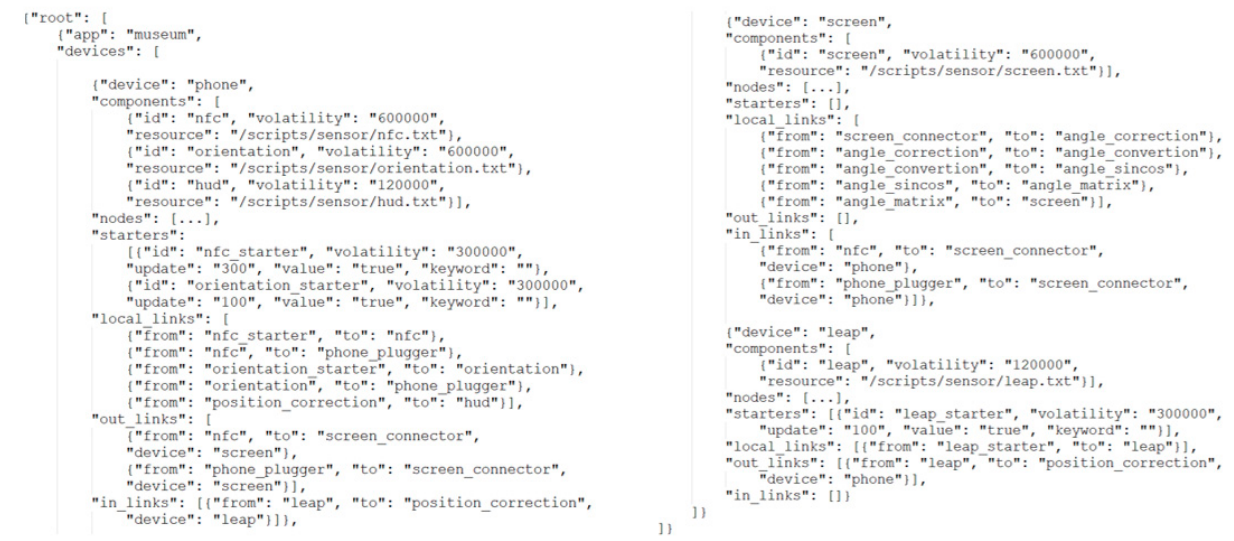
Figure 7. The JSON configuration for the MusExp App with the two applets for the smartphone device merged.